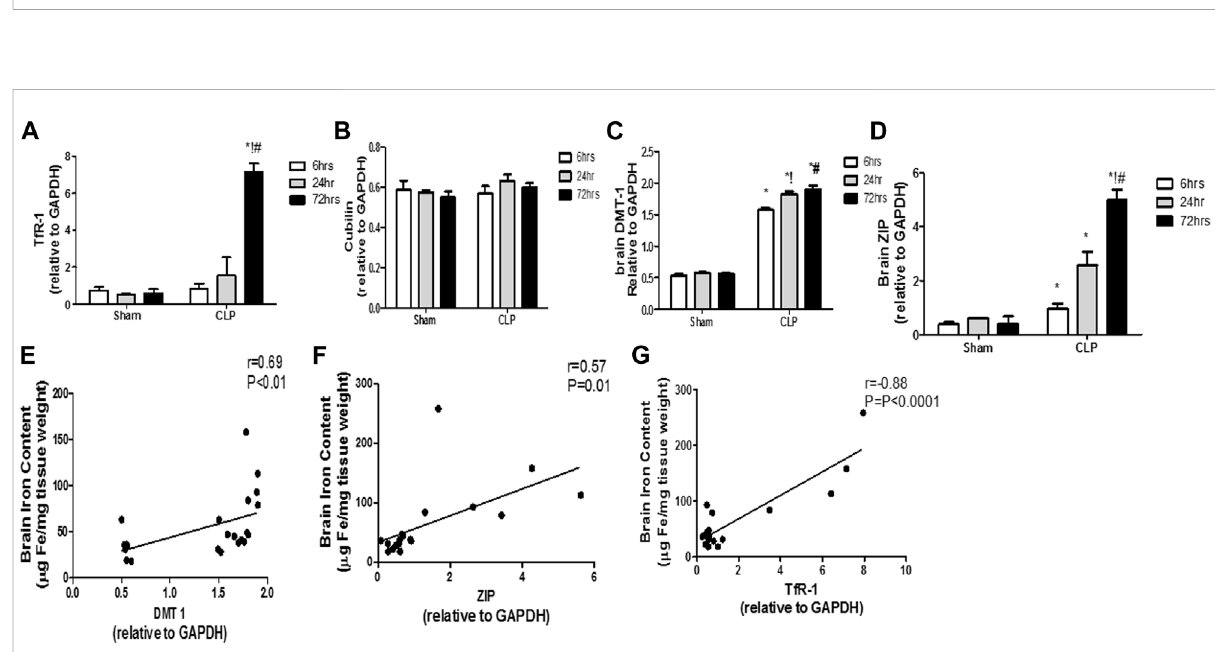
FIGURE 9 Transferrin- and non-transferrin-bound iron-uptake gene expression in the brain during sepsis. (A – D) Quantitative real-time reverse- transcription polymerase chain reaction analysis of the transferrin receptor protein 1 (TfR-1) (A) , cubilin (B) , the divalent metal transporter 1 (DMT-1) (C) , and the brain zinc transporters (ZIP) (D) . The expression levels of transferrin-bound iron transporters (TBI) (TfR-1 (A) and cubilin (B) ) in the brain during sepsis were not altered, whereas sepsis increased the expression of NTBI transporters (DMT-1 (C) and ZIP (D) ). (E – G) Pearson ’ s correlation analysis between the iron level in the brain and the DMT-1 (E) the ZIP (F) and the TfR-1 (G) . Data are the means ± SEM. * p < 0.05 vs. the corresponding sham group; ! p < 0.05 vs. the 6 h CLP group; # p < 0.05 vs. the 24 h CLP group. N = 10 rats per